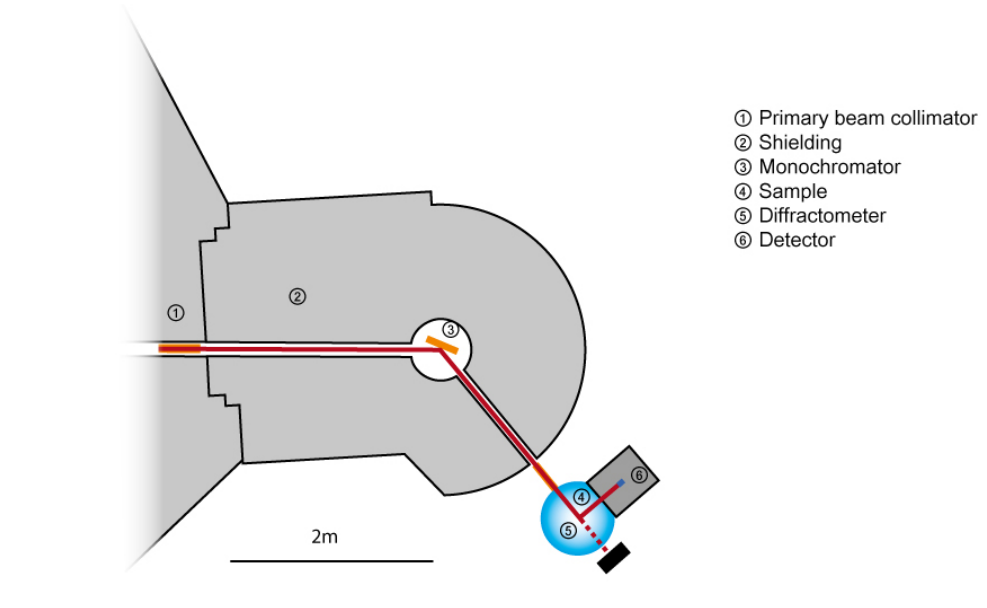
Figure 2: Schematic drawing of